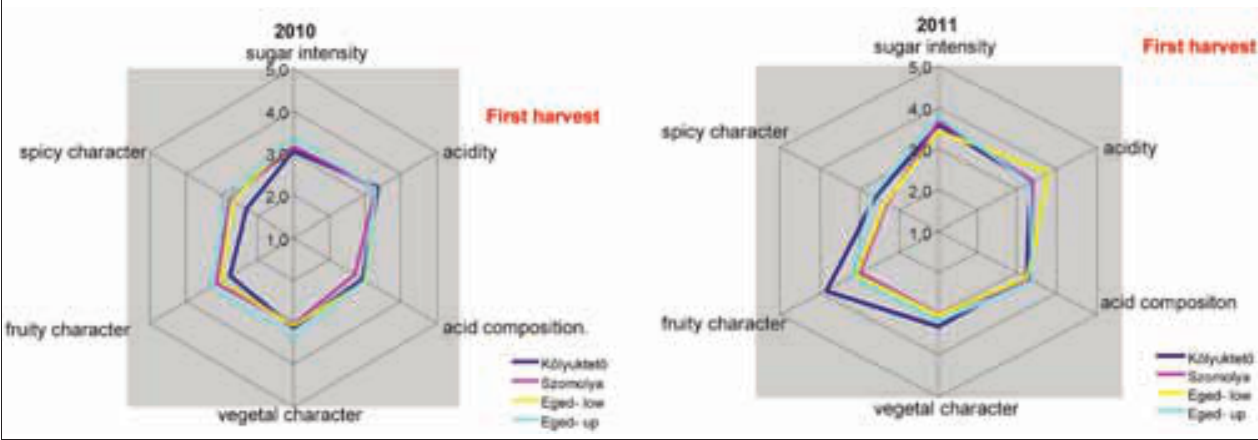
Figure 2a: Main sensorial characters of the pulp (2010-2011- First harvest